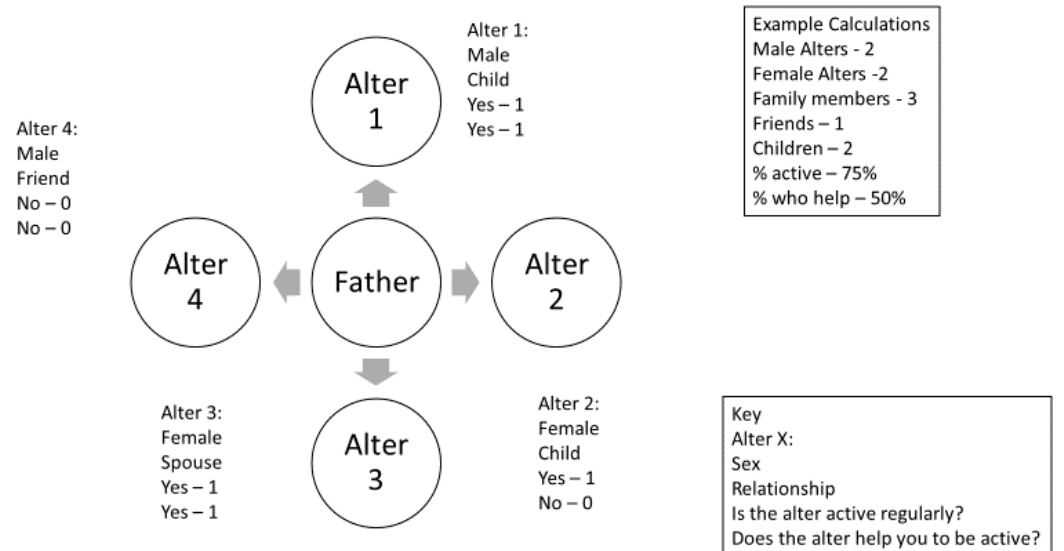
Figure 1. Example father network and calculations.